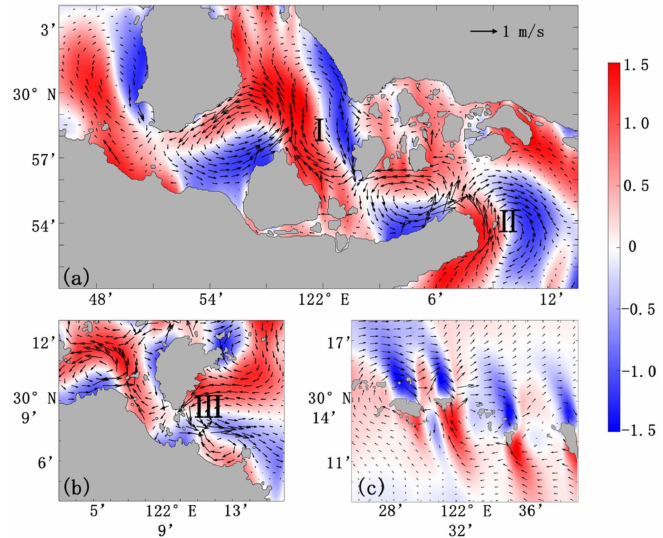
Figure 9. The tidal residual currents and TCA in ( a ) the Luotou Channel ( b ) the Guanmen Channel, and ( c ) the Dongji